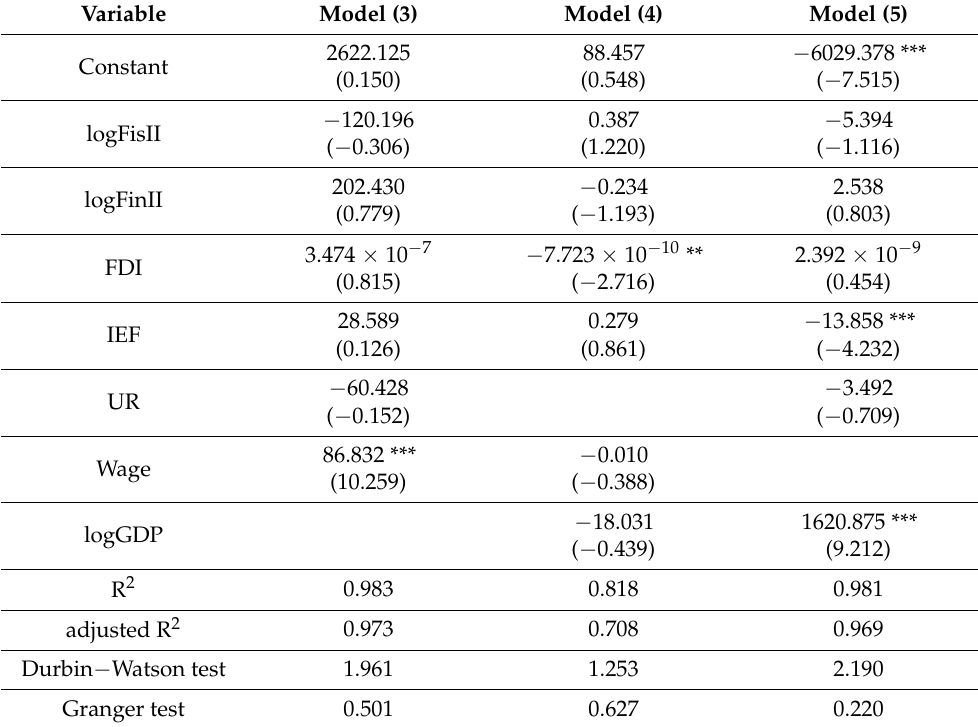
Table 4. Regression results of models